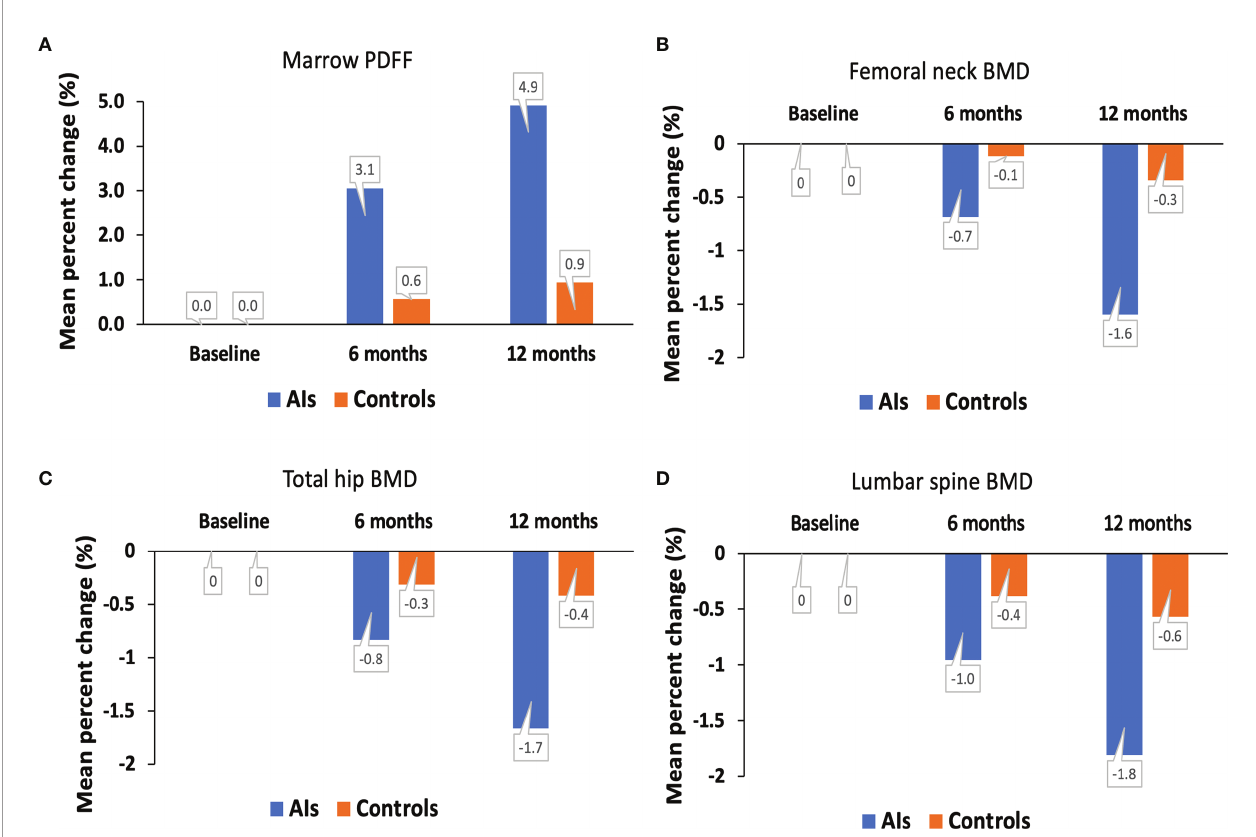
FIGURE 3 | Mean percent change in marrow PDFF (A) , BMD at the femoral neck (B) , total hip (C) and lumbar spine (D) over time. AIs, aromatase inhibitors; BMD, bone mineral density; PDFF, proton density fat fraction.